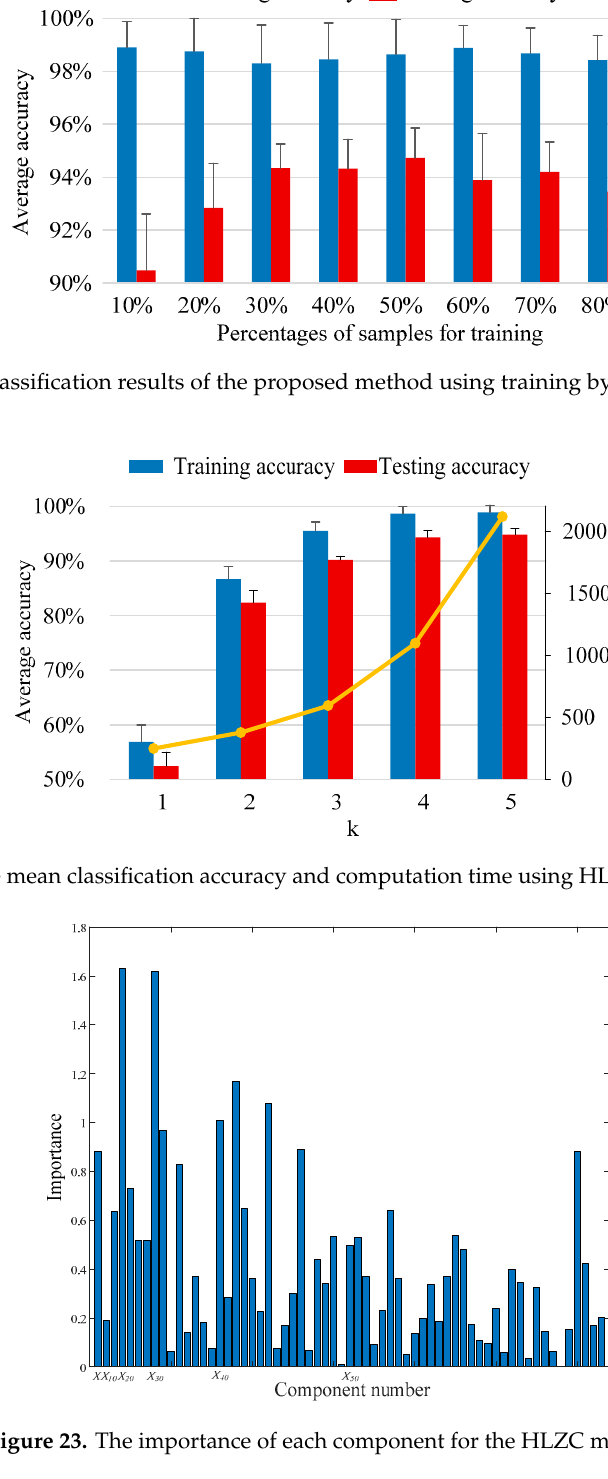
Figure 23. The importance of each component for the HLZC method.